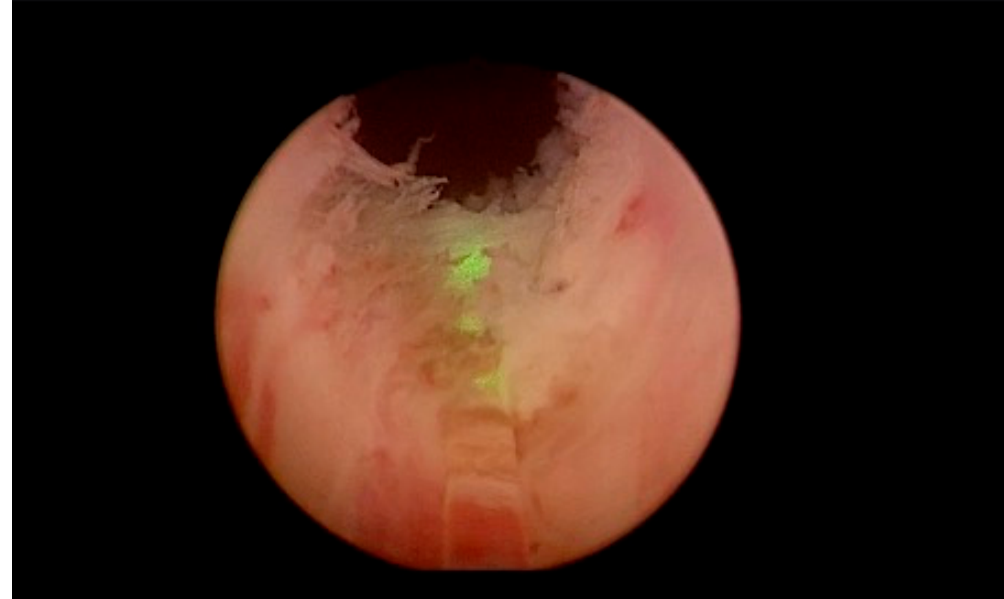
Figure 3. Bladder neck incision.